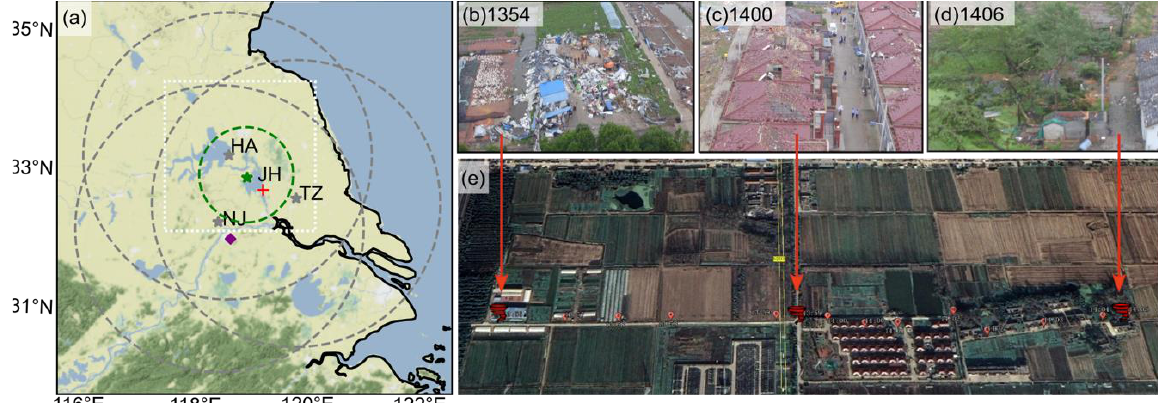
Figure 1. ( a ) The locations of the tornado and different observations used in this study. The gray (green) stars and the gray (green) dotted circles represent the location and the 230 km (75 km) observation radius of the S-band (X-band) radars. The red cross represents the tornado location. The purple diamond represents the NJ sounding station. The white dotted square represents the three-dimensional wind retrieval region. ( b – e ) The images of ground damage survey.